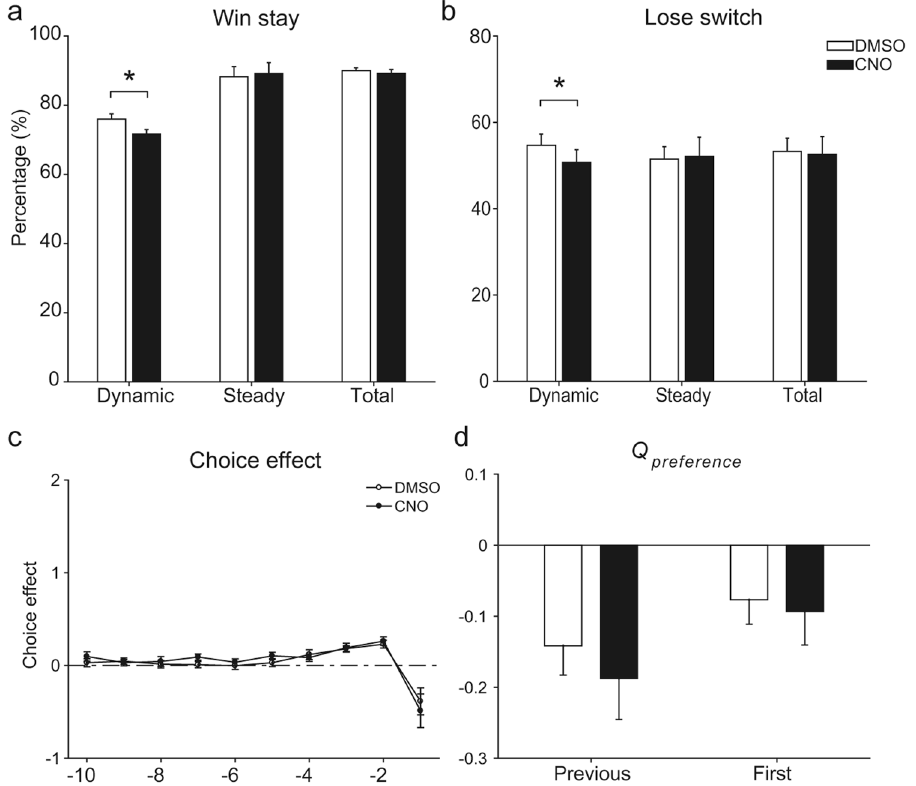
Figure 7. Analysis results related to behavioral inhibition role of CA1. ( a , b ) Proportions of win-stay and lose-switch are shown for all (Total), dynamic-state (Dynamic), and steady-state (Steady) trials. ( c ) Average regression coefficients from a logistic regression model (Eq. 2) showing the effects of past choices on the animal’s current choice. Negative coefficients indicate the animal’s tendency not to choose the same target. ( d ) Choice biases ( Q preference ) toward the previous high-value target (Previous) and toward the first high-value target for a given session (First). Negative coefficients indicate the tendency to inhibit the choice bias. All graphs are mean ± SEM across 11 CaMKIIa-Cre mice. * p < 0.05 (paired t